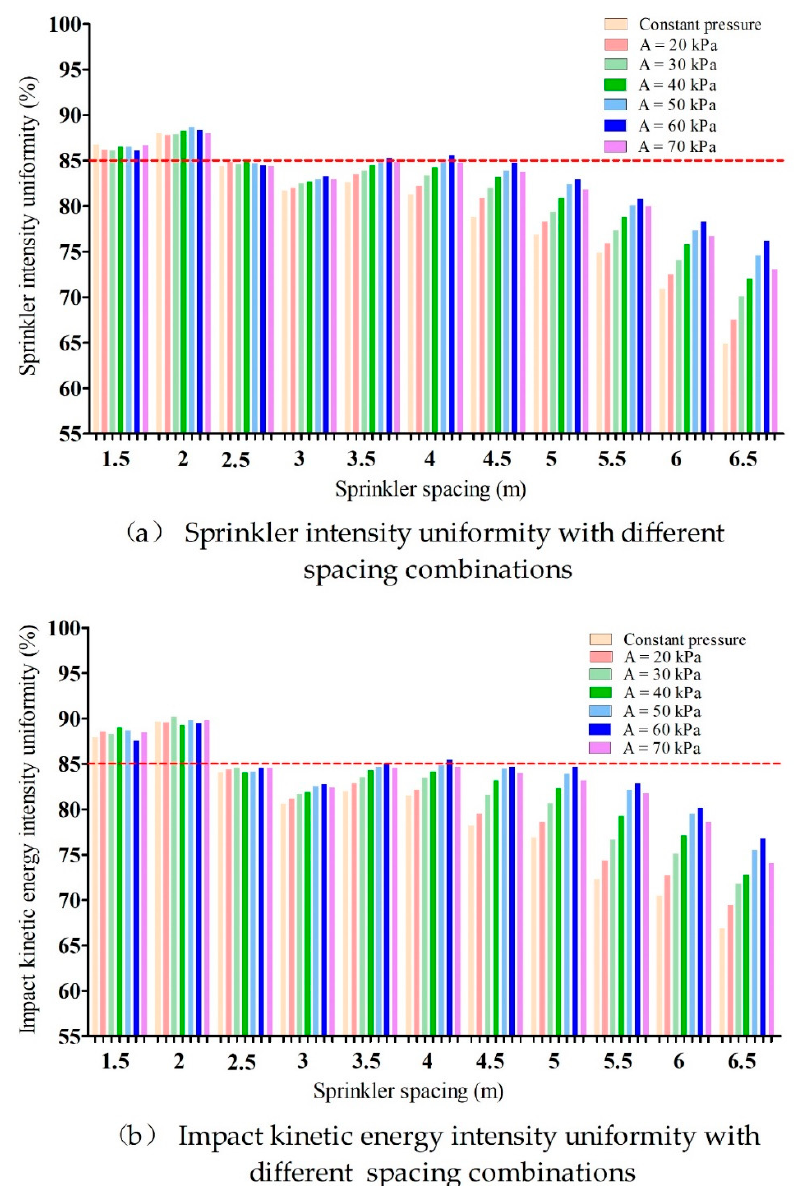
Figure 10. Sprinkler intensity ( a ) and impact kinetic energy intensity ( b ) uniformity with different spacing combinations.